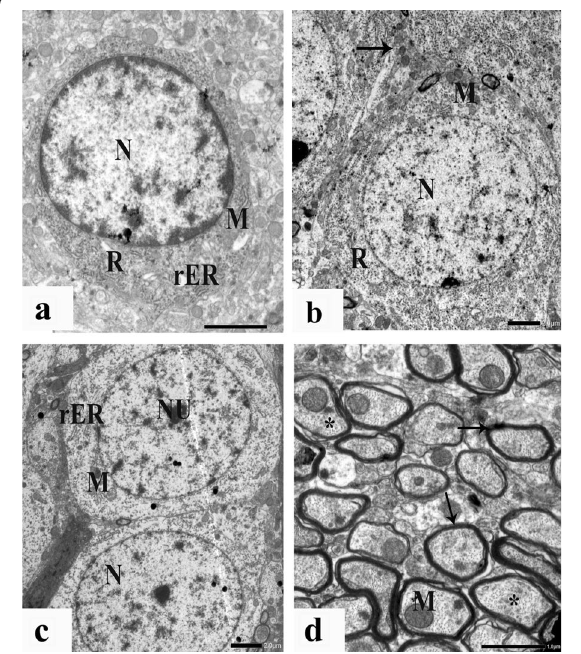
Fig.6 Electron micrograph of the cerebral cortex obtained from the control rat a : showing a granule cell has rounded nucleus (N), rough endoplasmic reticulum cisternae (rER), free ribosomes (R) and mitochondria (M). b & c : pyramidal cells with large apical dendrite (thin arrow) oval nucleus (N) with fine granular chromatin, prominent nucleolus (Nu), mitochondria (M), rough endoplasmic reticulum (rER), and excess free ribosomes (R). d : myelinated axon with regular myelin sheath (arrow) and normal mitochondria (M) within homogenous axoplasm either with irregular nuclear envelope and abnormal chromatin distribution or shrunk with marked indenta-